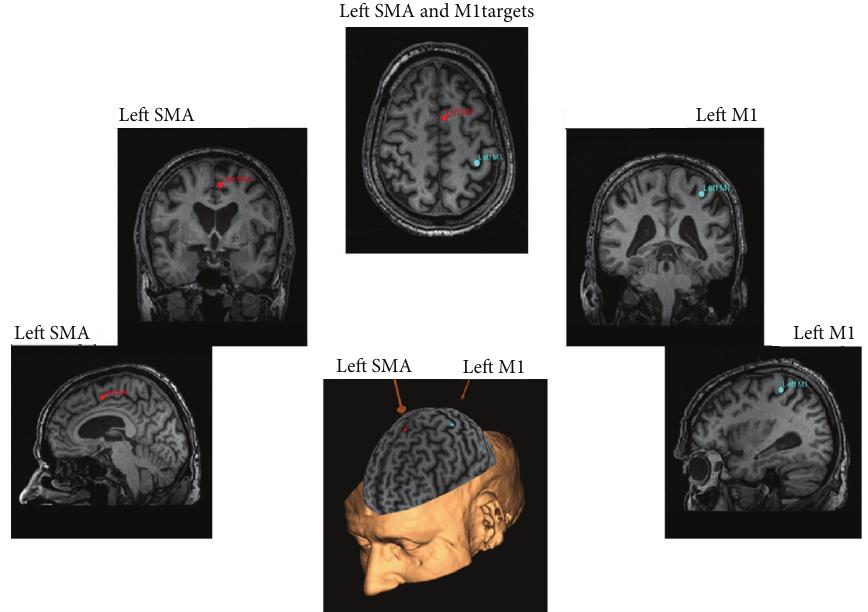
Figure 1: Stereotaxic system for coil placement. Brainsight was used to locate left SMA (as per Talairach coordinates) and left M1; markers were placed to ensure accuracy of coil placement within and across stimulation